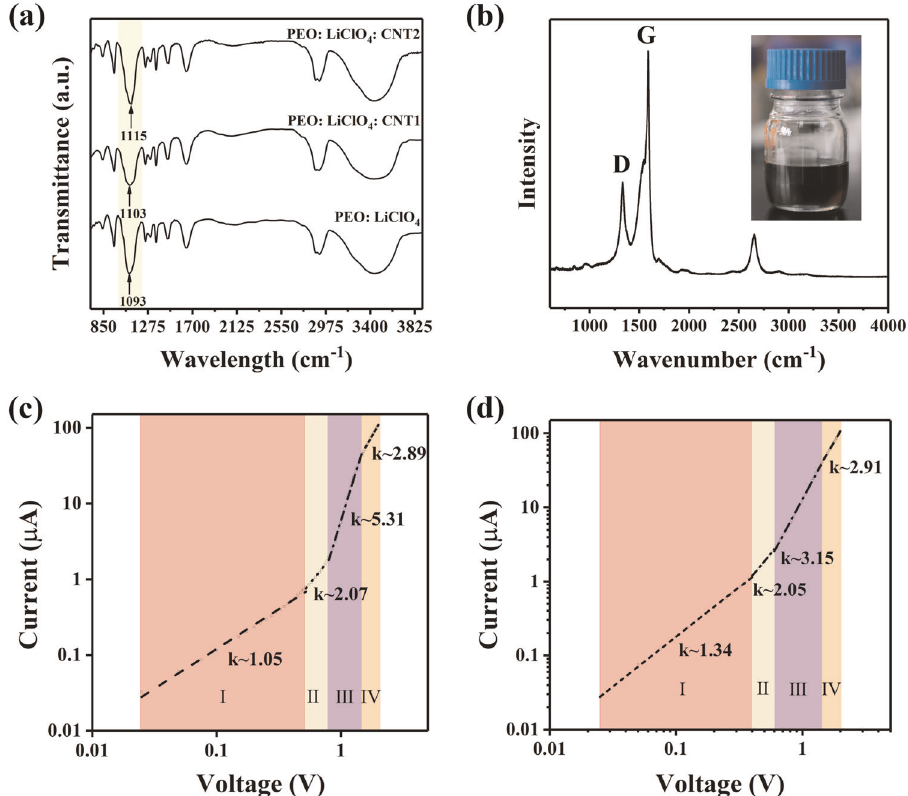
Fig. 2 Investigation of the underlying mechanism for the synaptic behaviors. a The FTIR spectra for PEO: LiClO 4 , PEO: LiClO 4 : CNT1, and PEO: LiClO 4 : CNT2. Changes in the highlited frequency region indicates the interaction between s-SWCNTs and PEO: LiClO 4 . b The presence of D-band in Raman spectra is a diagnostic of disorder and sidewall defects. The relative intensity of the D-band to G-band of 0.43 indicating the functionalization of the s-SWCNTs. The ionic behaviors were uncovered by the investigation of the conduction mechanism for the forward and reverse IV characteristics plotted in log scale in c , d